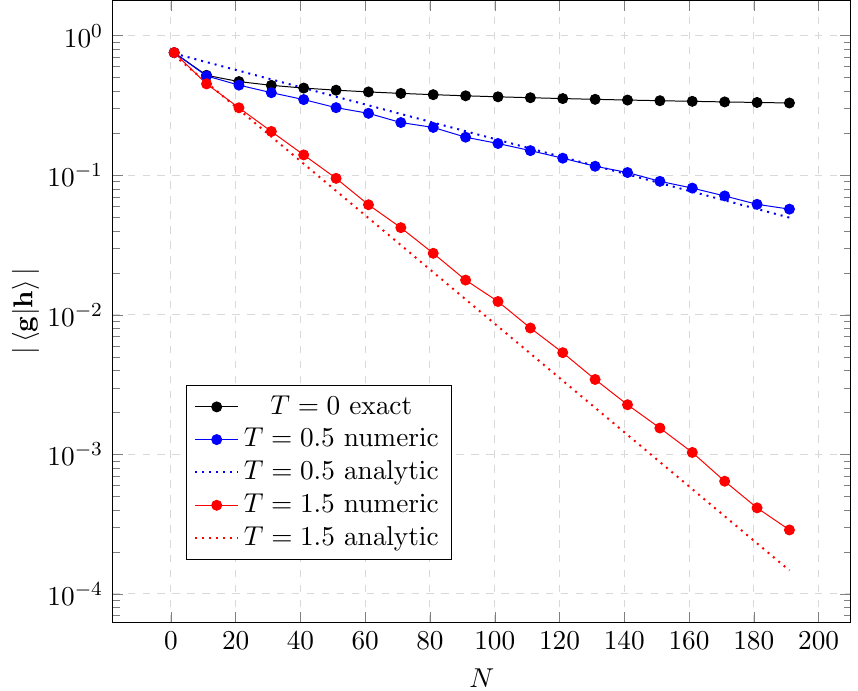
Figure 3: Diagonal overlap scaling plotted against system size on semi-logarithmic axes. Included are the exact values for the ground state, (20), in black. Then for T = 1 in blue and T = 3 in red, the solid disks are the geometric mean of 1000 2 2 states sampled numerically from the Gibbs ensemble at that N . Compare them to the dotted lines, which are the simple prediction as in (32). It is clear that for finite temperature, scaling is essentially exponential, for zero temperature sub-exponential. ν = 0.4, L = N